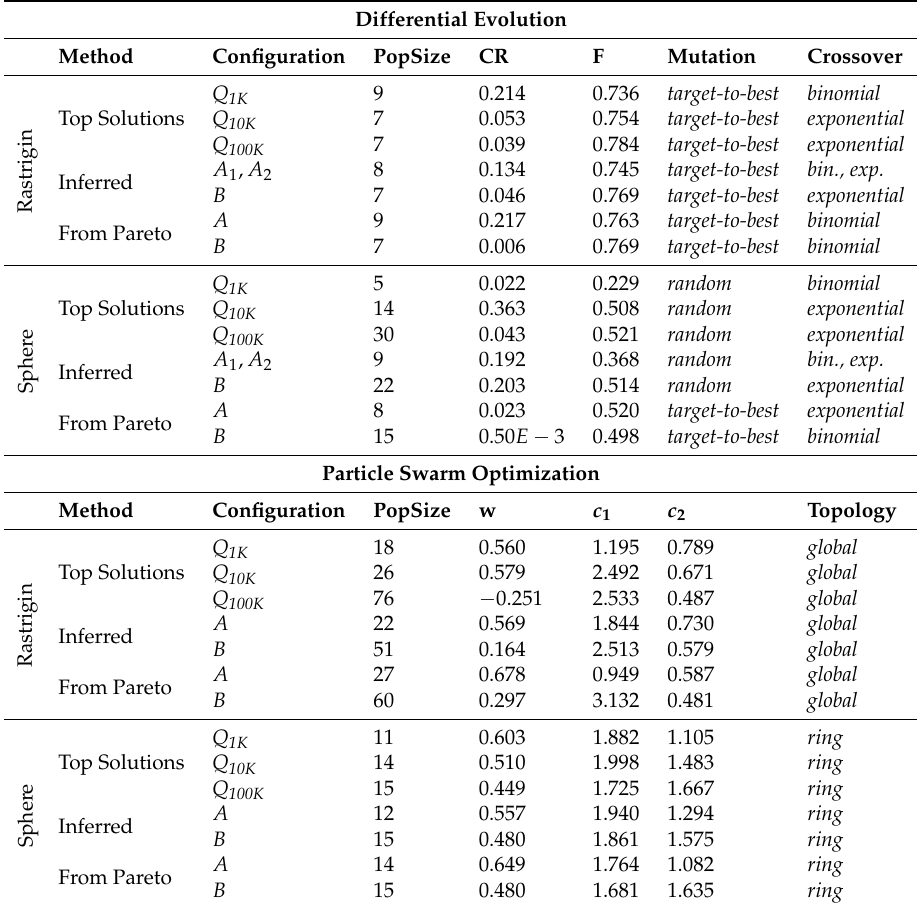
Table 4. DE and PSO configurations for the same objective function with three different fitness evaluations budgets.“Top Solutions” are the best-performing sets on each objective; “Inferred” refers to the ones obtained averaging Top Solutions; “From Pareto” are extracted from the Pareto front obtained considering the objectives pairwise (see Figure